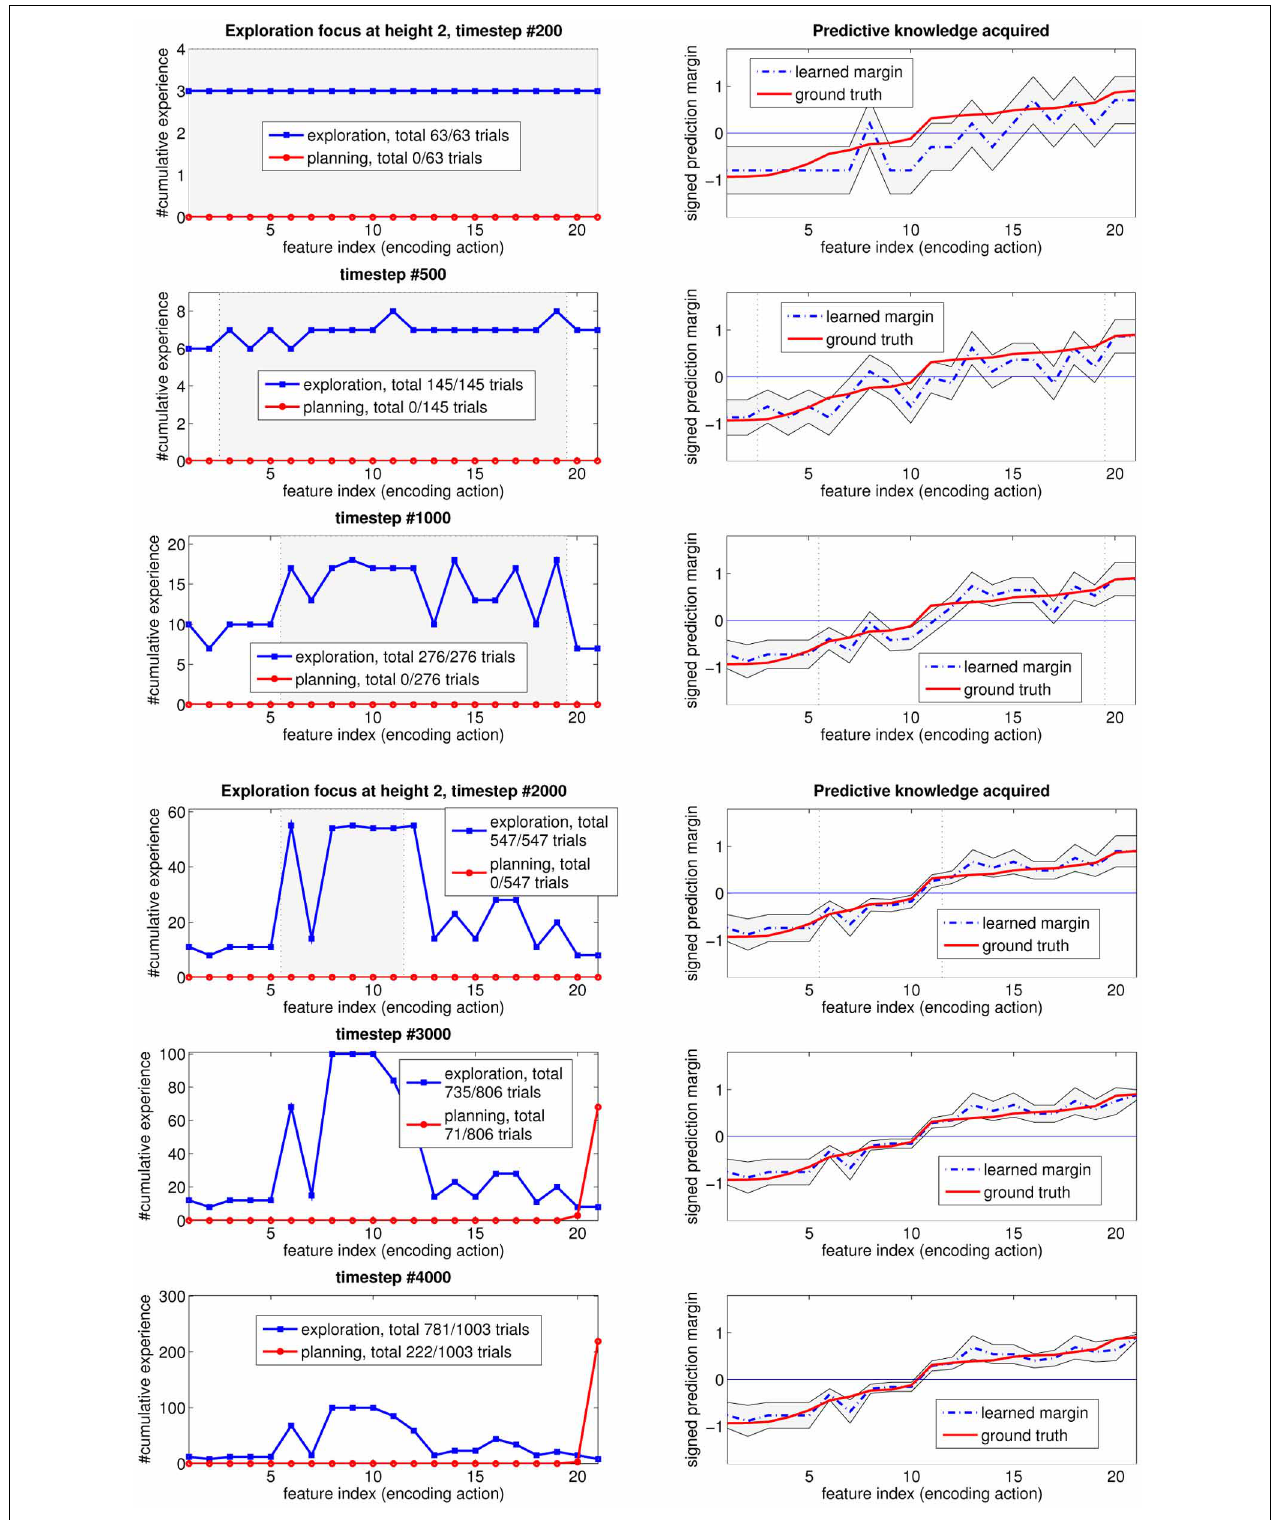
FIGURE 7 | How the focus of the self-generated exploration goals at height 2 changes over time as the learned predictive model gets closer to the true one.